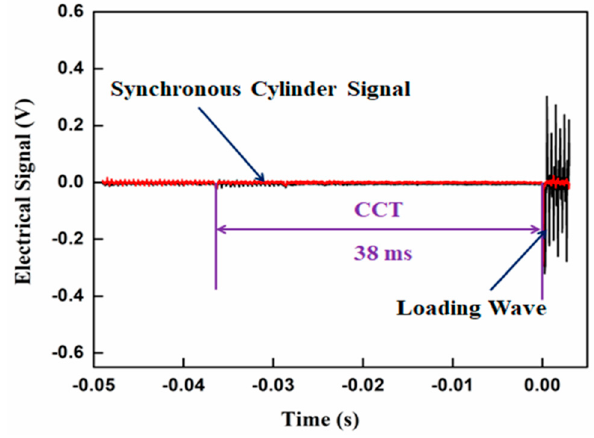
Figure 6. Cold contact time (CCT) diagram.